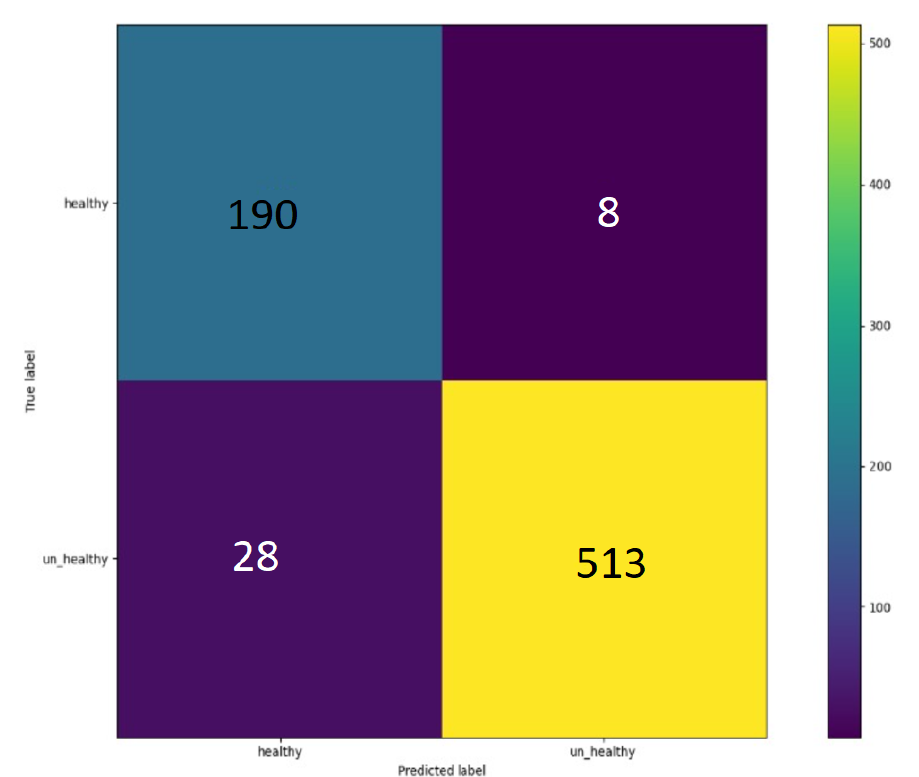
Figure 30. Confusion matrix for YOLOv5: healthy images (190) identified, 513 images were unhealthy and correctly identified.